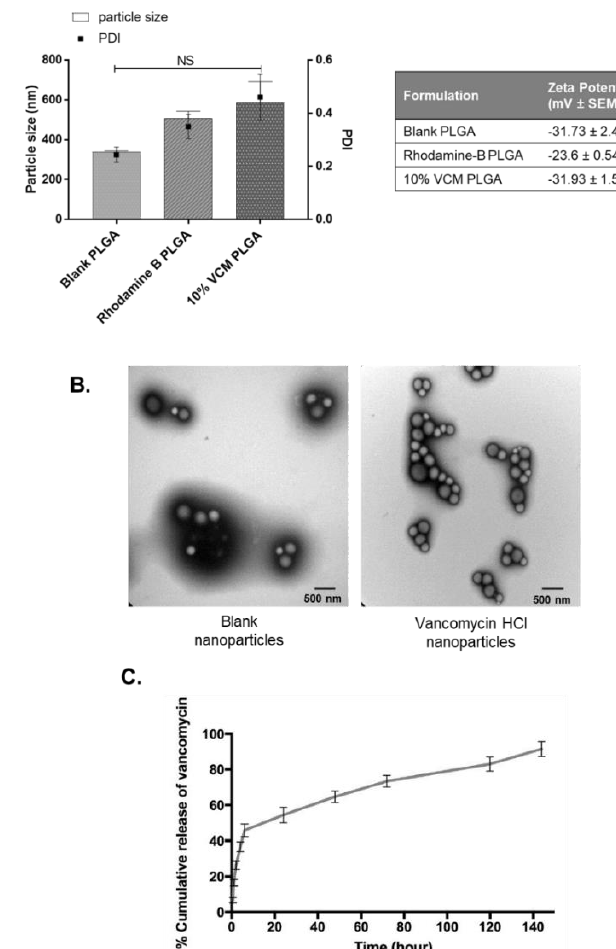
Figure 4. Comparative analyses of formulated nanoparticles. ( A ) The blank, Rhodamine B-, and 10% vancomycin HCl-loaded nanoparticles were cross-examined to assess the effect of drug encapsulation on particle size, PDI, and zeta potential. There was no significant difference in particle size or PDI between the nanoparticles, and all 3 nanoparticles displayed negative zeta potentials and even size distributions. ( B ) Transmission electron images of blank (left) and vancomycin HCl- (right) loaded nanoparticles indicate the heterogeneity of each particle size, all displaying smooth spherical shapes. Scale bars at 500 nm. ( C ) An n vitro drug release profile was calculated using a PUR-A-LYZER mini 6000 dialysis kit. This indicates cumulative percentage increase in vancomycin from nanoparticles over 144 hrs. Results are the mean values ± SEM of three independent experiments using 1-way ANOVA followed by Tukey’s post hoc